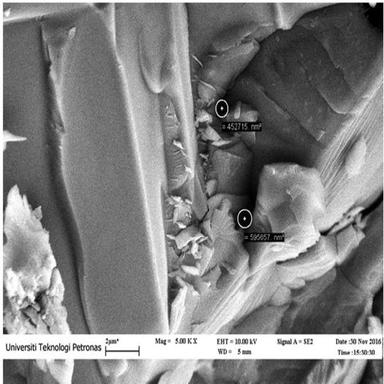
(b): FESEM image of Coal bottom ash at a 1000x and 5000x magnification.